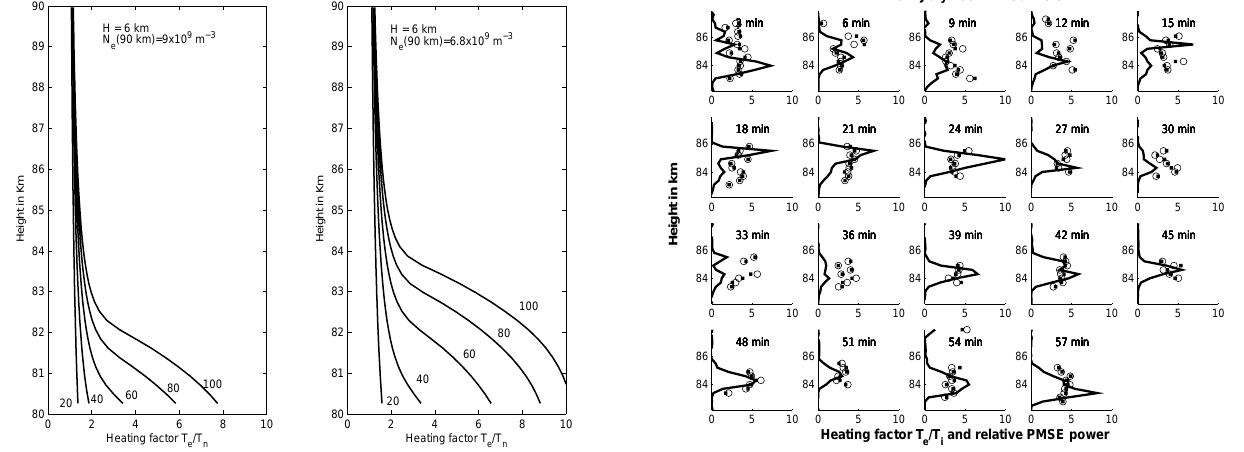
Fig. 8. Here we show the heating factor as a function of height for each of the 19 overshoot cycles in the one hour of observations shown in Fig. 6. The PMSE relative height power profiles, nor- malized to an arbitrary value of 10 for the largest value, are also shown. The filled squares are the results when the PMSE intensi- ties at points 0 and 1 (Fig. 3) are found from a best fit second-order polynomial through the 10s before or after the heater is switched on. The open circles are the results from using the 2-s integrated values at point 0 and at point 1.